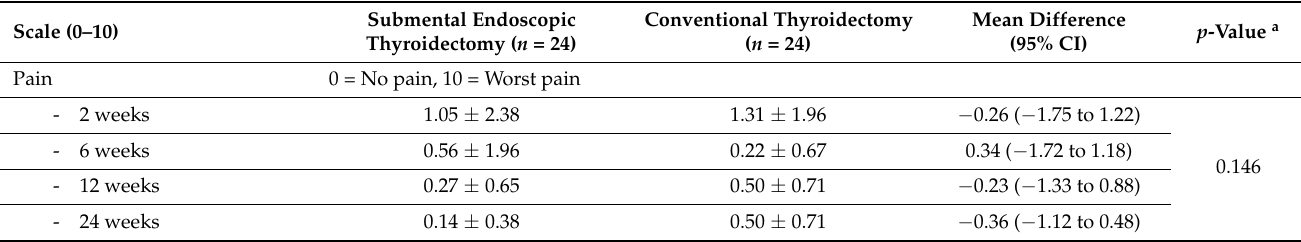
Table 3. Results of the surgical outcomes